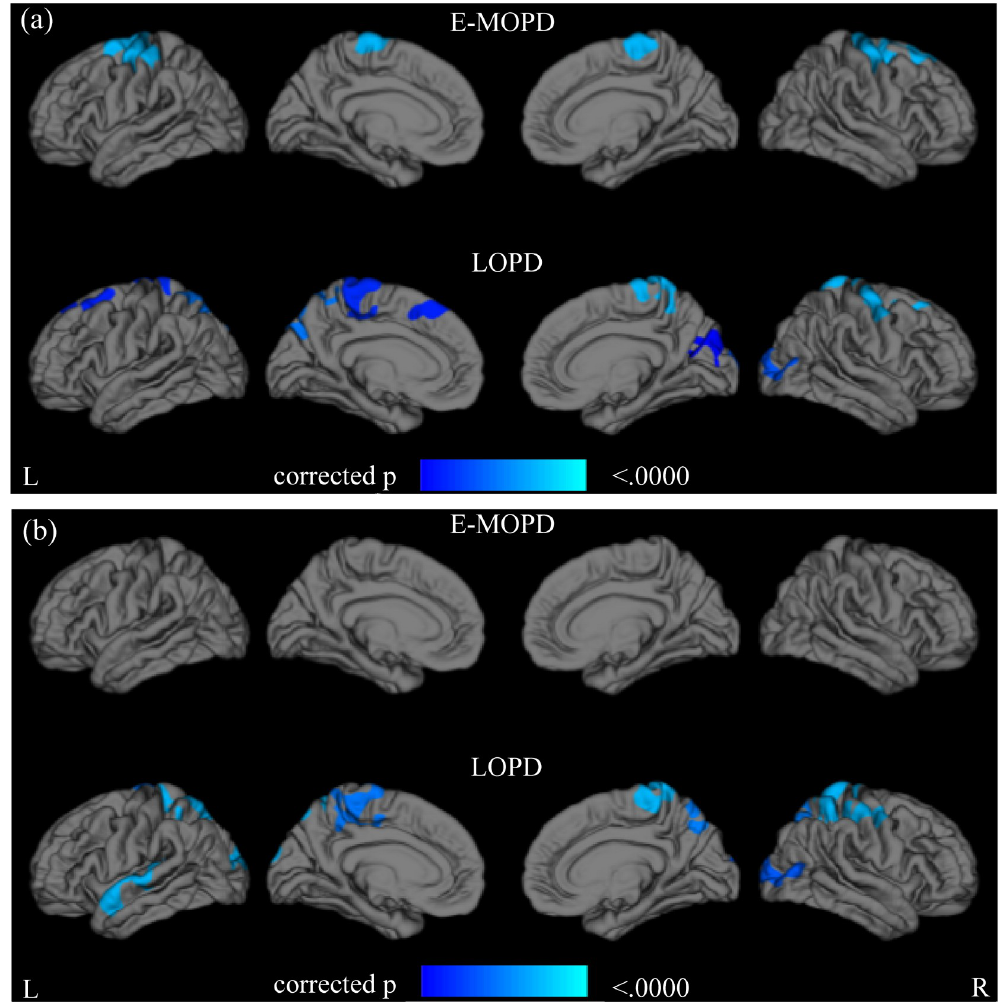
Fig 2. Correlation between cortical thickness and disease progression in E-MOPD and LOPD. (a) Areas of cortical thinning with prolonged disease duration. (b) Areas of cortical thickness thinning with an increase in LEDD. LEDD, levodopa equivalent daily dose; E-MOPD, early or middle-onset Parkinson’s disease; and LOPD, late-onset Parkinson’s disease. Between-group differences in the slope of regression lines between cortical thickness and disease progression. When using the disease duration as an index of disease progres- sion, the precuneus displayed more rapid cortical thinning in the LOPD group than in the E-MOPD group (p < 0.05) (Fig 3). When using LEDD as an index of disease progression, the bilateral superior temporal gyrus, paracentral lobule, superior parietal lobule, occipital lobule, right superior frontal gyrus, middle frontal gyrus, temporal pole, left precentral gyrus, left post- central gyrus, and precuneus revealed more rapid cortical thinning in the LOPD group than in the E-MOPD group (p < 0.05) (Fig 3). There were no areas of rapid cortical thinning in the E-MOPD group compared with the LOPD group. S4 Table presents information on the identi- fied clusters.